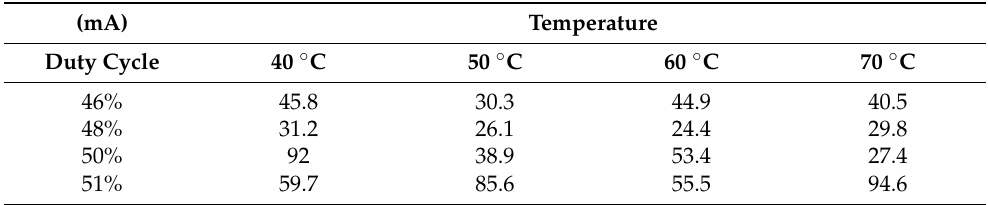
Table 4. Mean absolute error (in mA) of the inductor current for different duty cycles and tempera- tures for the SPICE simulations.